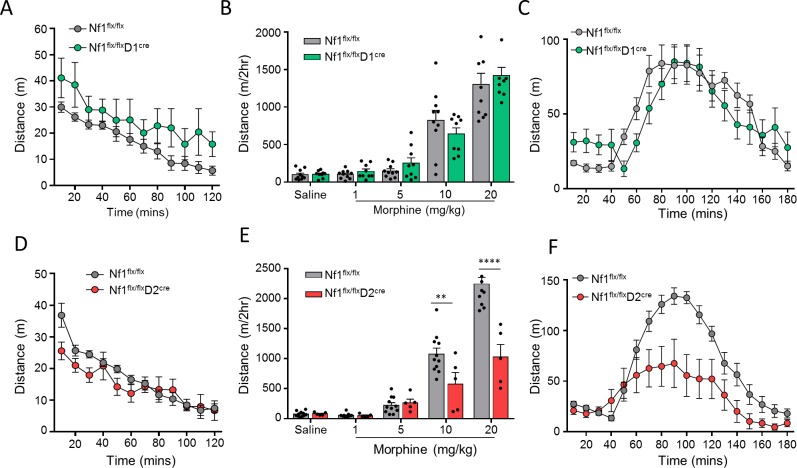
Elimination of NF1 in D2R-MSNs blunts morphine-induced locomotion.(A) Locomotor activity for naïve Nf1flx/flxD1Cre mice. n = 5–10 mice/group. (B) Cumulative distance traveled in the open-field chamber for varying concentrations of morphine (1, 5, 10, and 20 mg/kg) and (C) time course for 10 mg/kg morphine for Nf1flx/flxD1Cre mice. n = 9–10 mice/group. (D) Locomotor activity for naïve Nf1flx/flxD2Cre mice. (E) Cumulative distance traveled in the open-field chamber for varying concentrations of morphine (1, 5, 10, and 20 mg/kg) and (F) time course for 10 mg/kg morphine for Nf1flx/flxD2Cre mice. n = 5–11 mice/group. Data are represented as mean ± SEM. **P < 0.01, ****P < 0.0001, two-way RM ANOVA. Underlying data for this figure can be found in S1 Data. D2R, D2 dopamine receptor; MSN, medium spiny neuron; NF1, neurofibromin 1; RM-ANOVA, repeated measures analysis of variance.